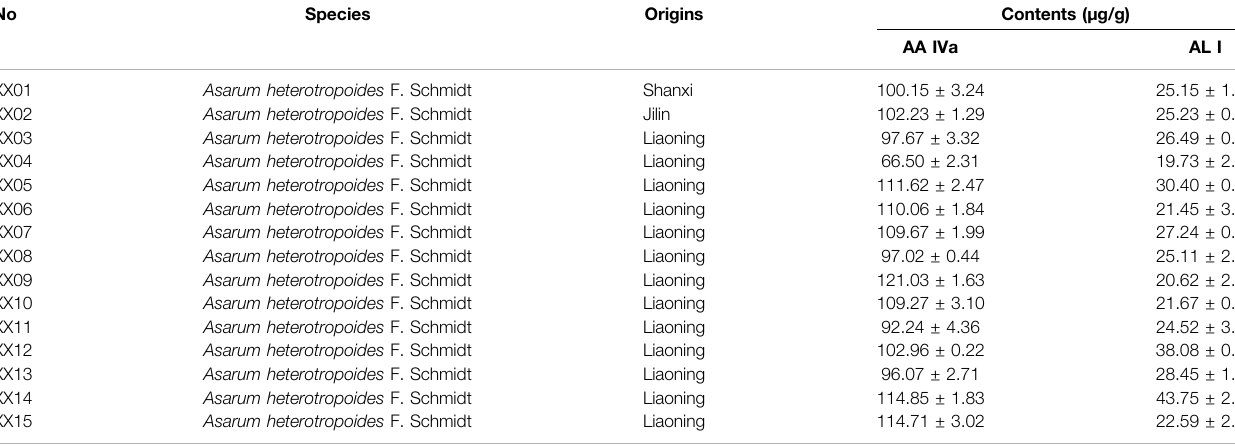
TABLE 1 | Plant information and contents of AA IVa and AL I in Asarum heterotropoides F. Schmidt (Xixin) No